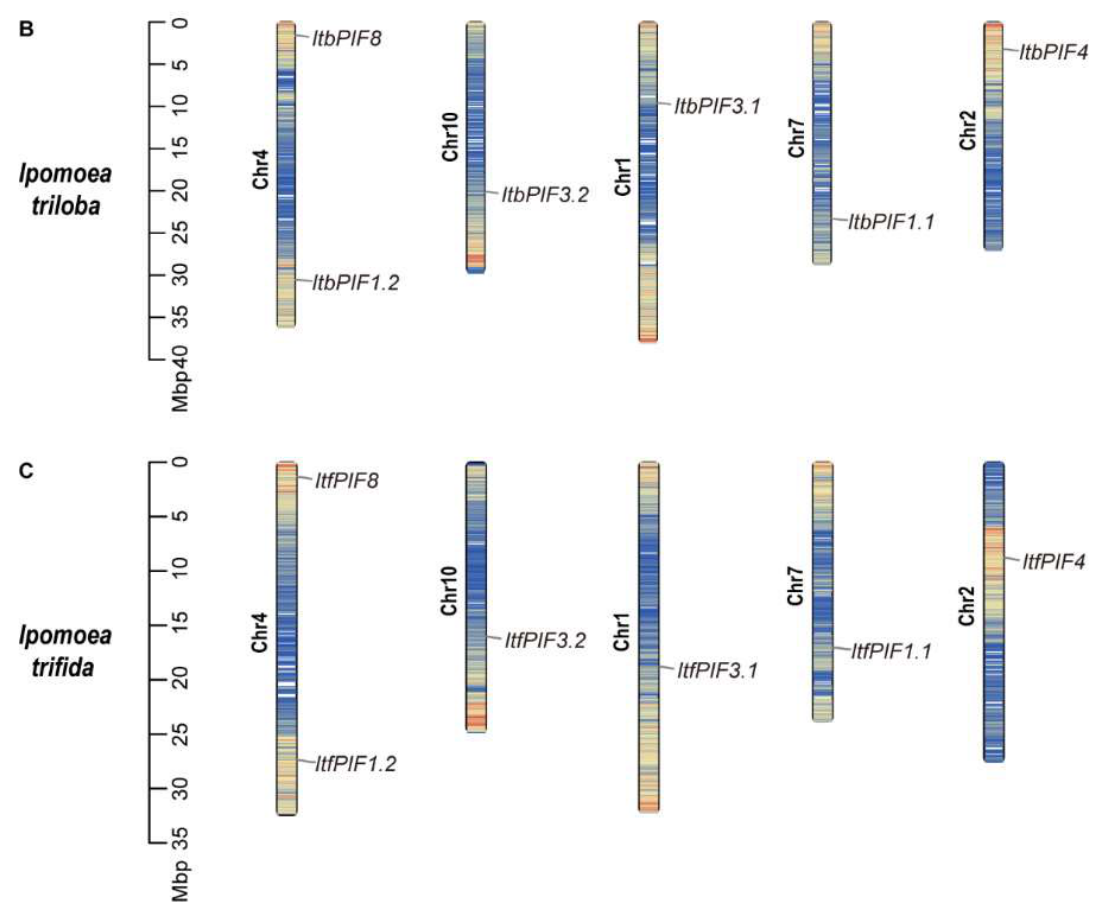
Figure 1. Chromosomal location and distribution of PIF genes in ( A ) I. batatas ; ( B ) I. triloba ; and ( C ) I. trifida . The bars represent chromosomes, the chromosome numbers are displayed on the left side, and the gene names are displayed on the right side. The relative chromosomal location of each PIF gene is marked with the black line at the right side.